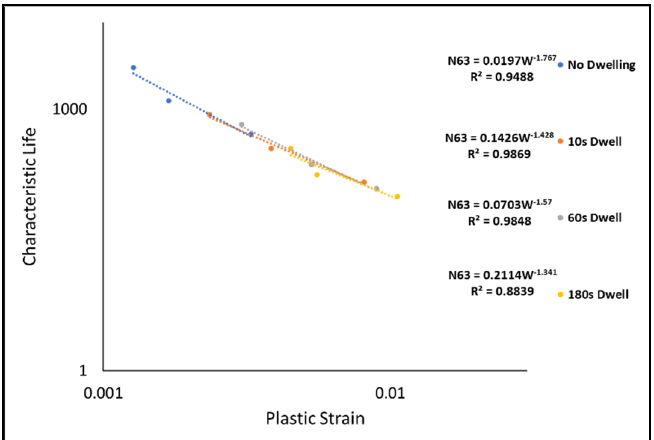
Figure 28. Characteristic life vs. plastic strain for SAC305 joints at various dwelling times on a log–log scale.